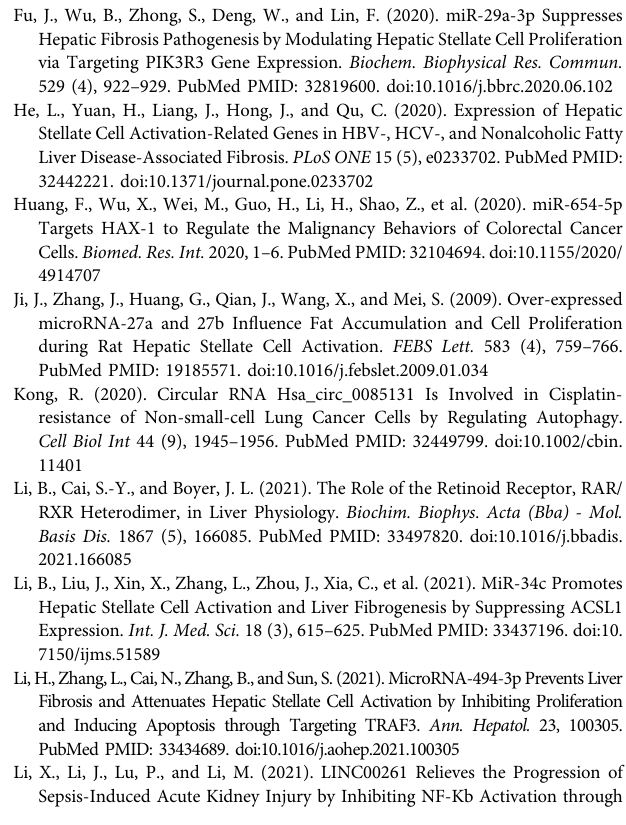
Supplementary Figure S1 | MiR-654-5p and RXR α expression levels in culture- activatedHSCs/quiescentHSCsaccordingtopreviousRNA-sequencingdata.Error bars represent mean ± SEM of experiments, **p < 0.01, and ***p < 0.001. Supplementary Figure S2 | The targeting relationship between miR-654-5p and RXR α in human predicted by the Targetscan database. Supplementary Figure S3 | The targeting relationship between miR-654-5p and RXR α in mouse predicted by the Targetscan